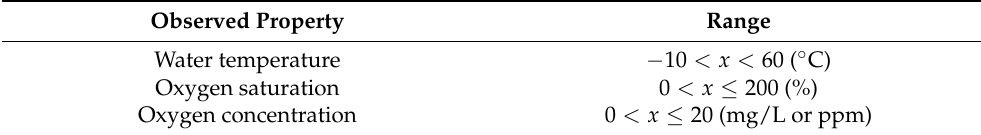
Table 3. Range test limits used at a data sensing